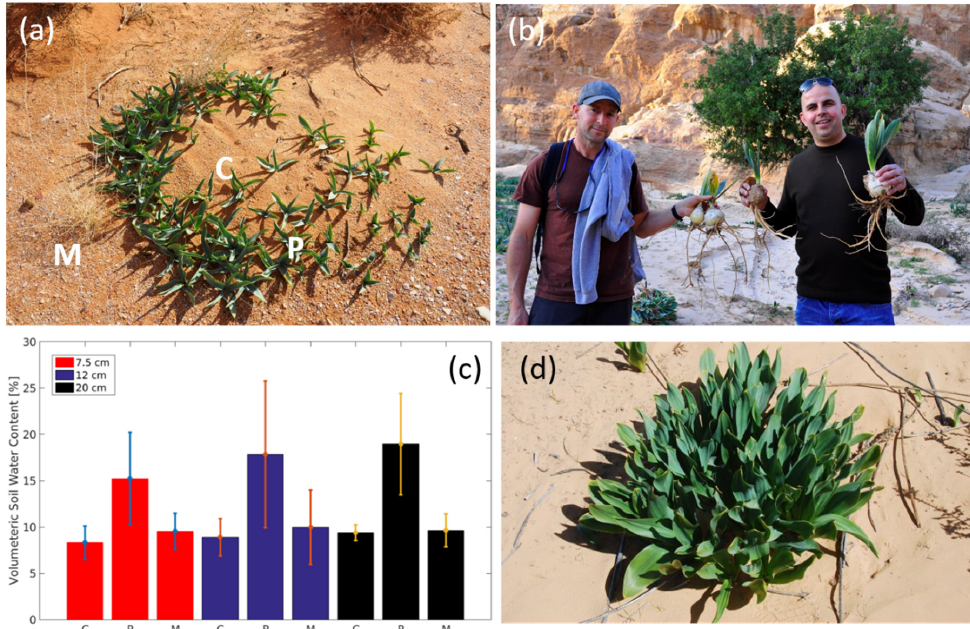
Figure 4. ( a ) A U. maritima ring indicating the three microenvironments: center (C), periphery (P), and matrix (M). ( b ) Two of the co-authors holding U. maritima plants that were uprooted and washed away by a flooding stream. Note the long and lateral roots of U. maritima (more than 30 cm in length). ( c ) Mean soil volumetric moisture content according to microenvironment and depth. ( d ) A spot of U. maritima growing on sand in the northern Negev Desert in Israel (mean annual precip- itation is about 150 mm/year).